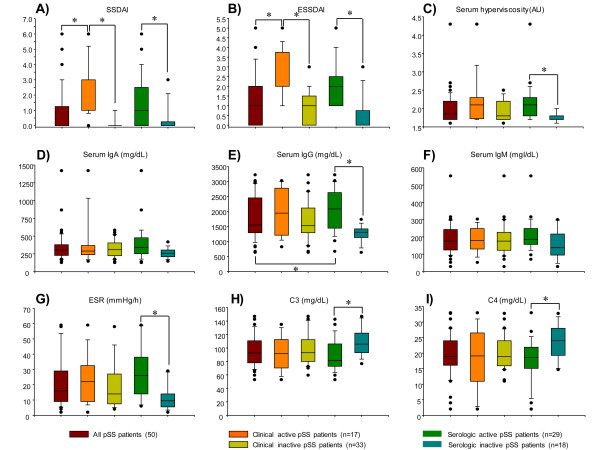
Clinical and laboratory data for patients with primary Sjögren's syndrome (pSS). Results are expressed as median, 10th, 25th, 75th, and 90th percentiles. *P < 0.05. SSDAI, Sjögren's syndrome disease activity index; ESSSDAI, European League Against Rheumatism Sjögren's syndrome disease activity index; Ig, immunobglobulin; ESR, erythrocyte sedimentation rate.